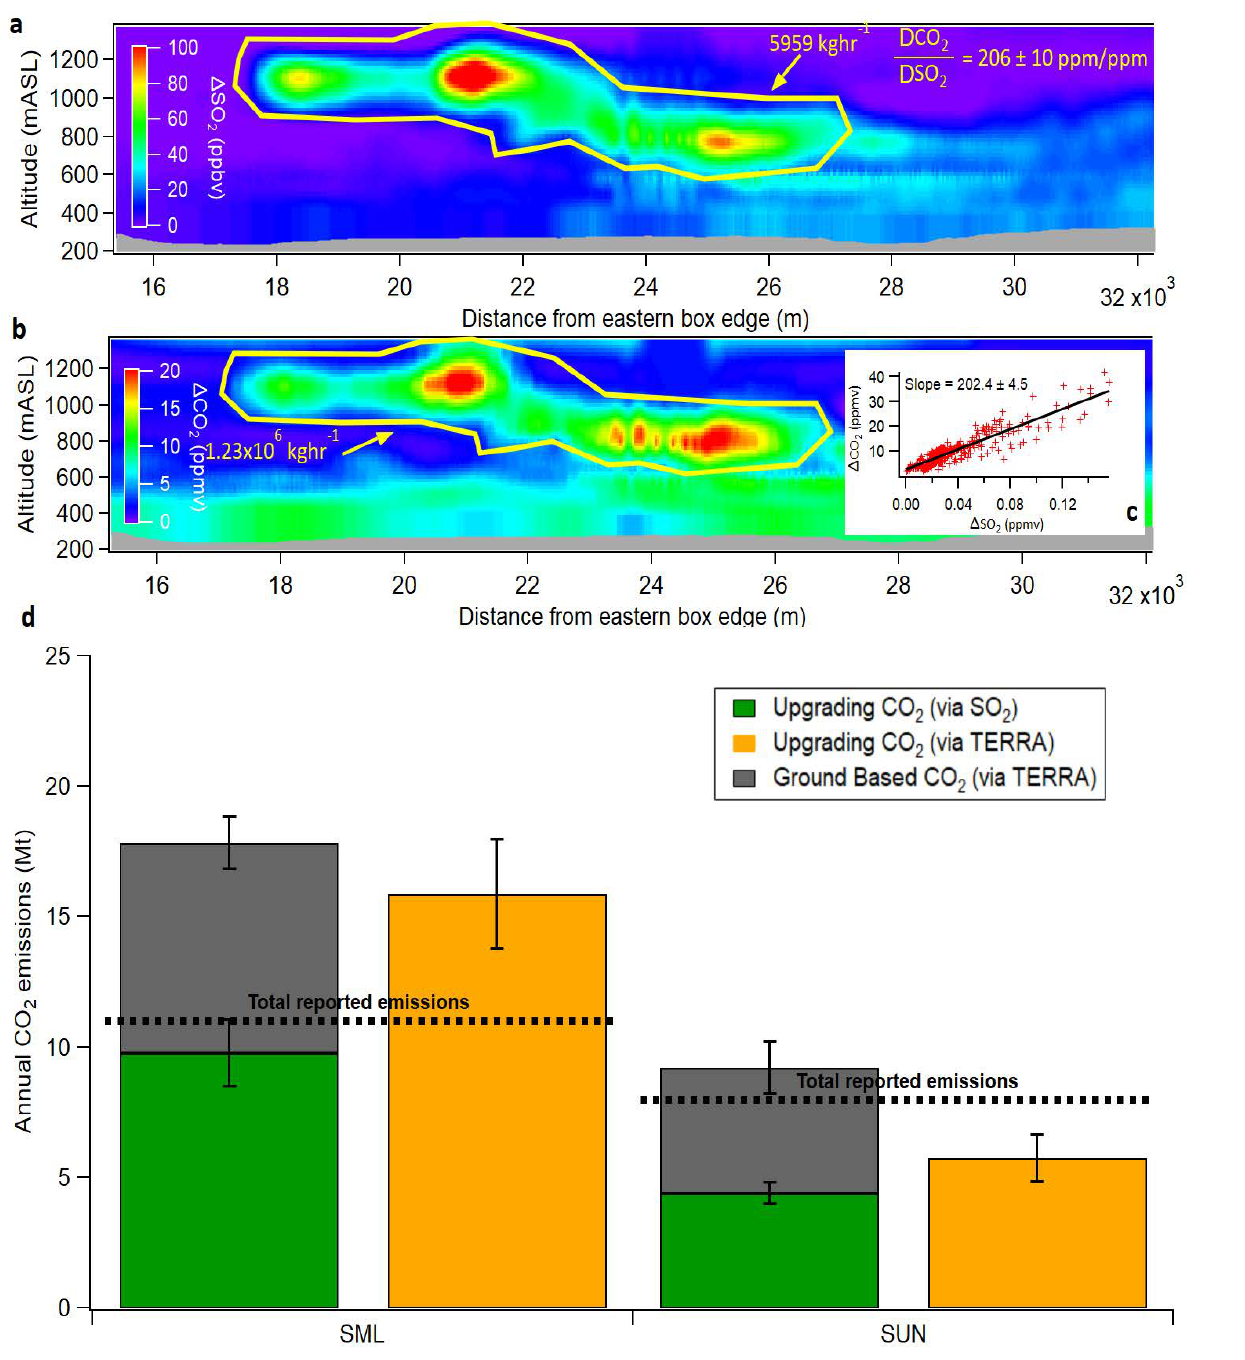
Fig. 3 Emissions of CO 2 for upgrading operations and ground-based sources in the oil sands. a Background subtracted SO 2 in elevated plumes from OS upgrading emissions during fl ight 18 derived with TERRA. b Background subtracted CO 2 in the same elevated plumes of fl ight 18. c Direct correlation between background subtracted CO 2 and SO 2 within plumes. d Annual emissions of CO 2 from upgrading stacks for SML and SUN derived using the CO 2 : SO 2 emission ratios measured in plume (green bars; see Methods). Orange and gray bars represent upgrading and ground-based emissions, respectively, derived using TERRA directly and up-scaled as described in Methods. Dashed lines represent total facility-reported CO 2 emissions to the GHG reporting program. Error bars in Fig. 2a, b represent the propagated uncertainty of the mean value. Source data are provided in Supplementary Data